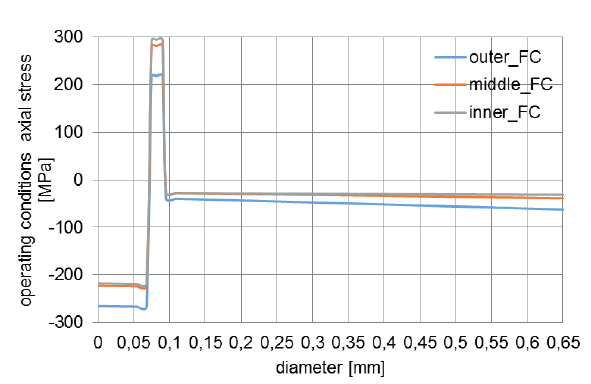
Figure 20: Axial stress distributions in the assembly: mSOFC stack, sealants, manifolds along the vertical centerlines of each layer (anode, electrolyte, cathode) for the top points of fuel cell.